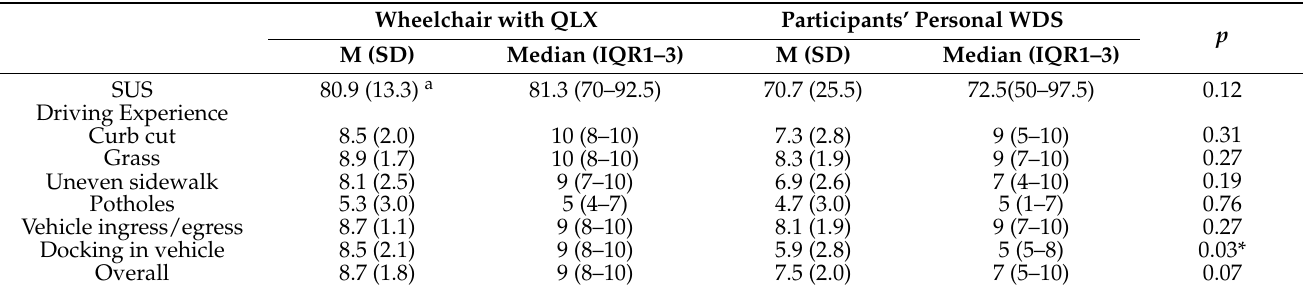
Wheelchair driving test results: Participants reported no significant differences in usability (SUS) between the QLX prototype and their own WDS (4-TD and EZ-Lock) (Table 2). With regard to wheelchair driving experience, participants reported better experience at docking a wheelchair using the QLX prototype in the vehicle compared to using their WDS ( p < 0.05). Similar results were shown if EZ-Lock users’ responses (n = 3) were excluded from the analysis. Table 2. Wheelchair driving test results (n = 15).